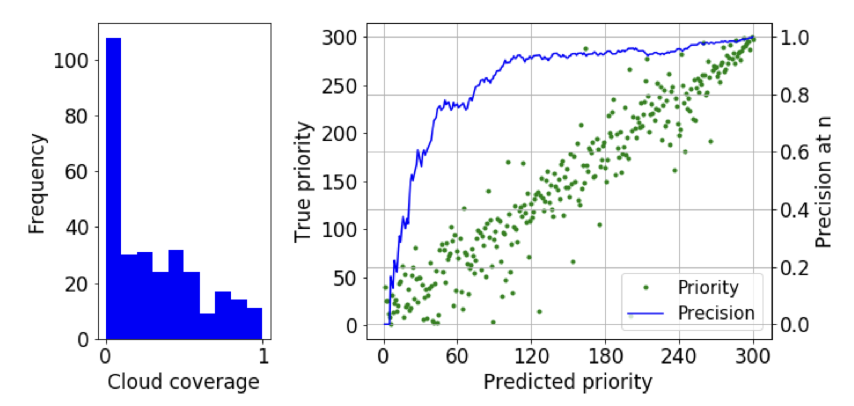
Figure 10. Prioritization result for clear image rich dataset. Spearman’s rank correlation coefficient ρ =